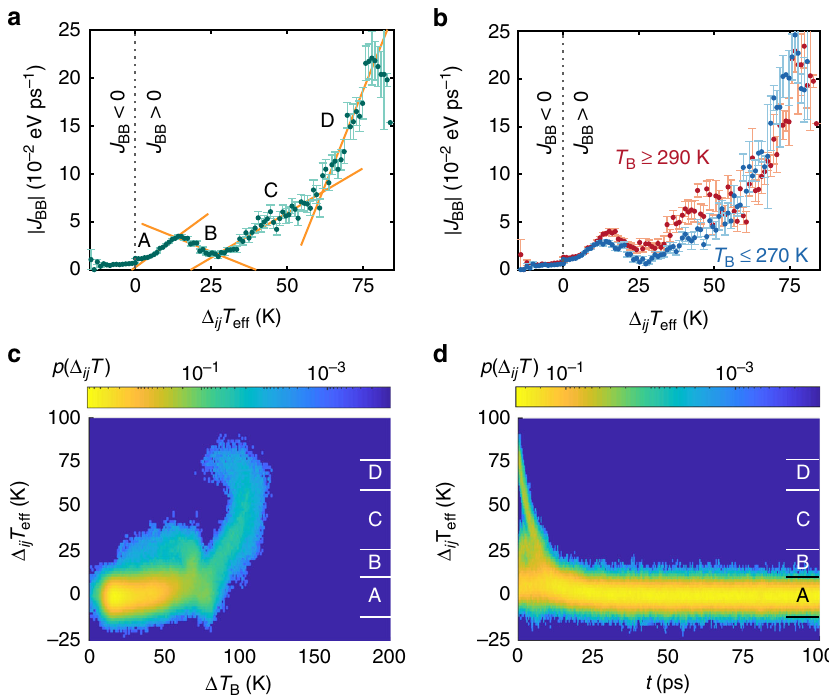
Fig. 3 Flux and thermal gradient distributions. a Backbone fl ux distributions ( J BB ) for helical Aib 10 conformers. Fluxes are parameterized by the effective temperature gradient Δ ij T eff between adjacent residues, and a positive fl ux corresponds to fl ow away from the heater along the backbone. Transport regimes are labeled parallel to the text (A through D) and with orange lines for visibility. b The J BB distribution may be partitioned into low – temperature (blue; 230 – 270 K) and high – temperature (red; 290 – 330 K) regimes. c Distribution of local temperature gradients Δ ij T eff versus average elevation Δ T B, t ) = 〈 T t ) 〉 − T t for the ensemble of MD trajectories. Labels ( a – d ) correspond to the regimes j ( j ( B over the bath temperature and d versus simulation time described in the text. Time series data from MD simulation is averaged with Δ t = 100 fs for fi ts to the master equation, Eq. (1), and the resulting fl uxes are block averaged in 1.0 K bins. The error bars are plus/minus one standard